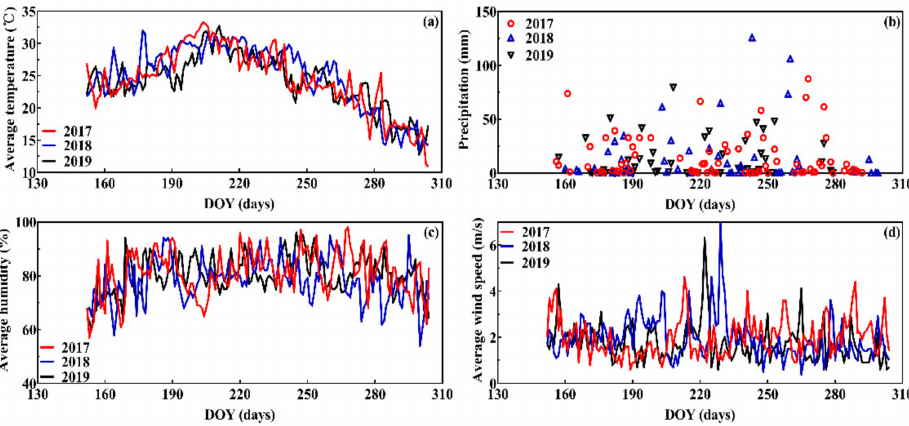
Figure 1. Daily average temperature ( a ), precipitation ( b ), average humidity ( c ), and average wind speed ( d ) during the rice growth seasons in different